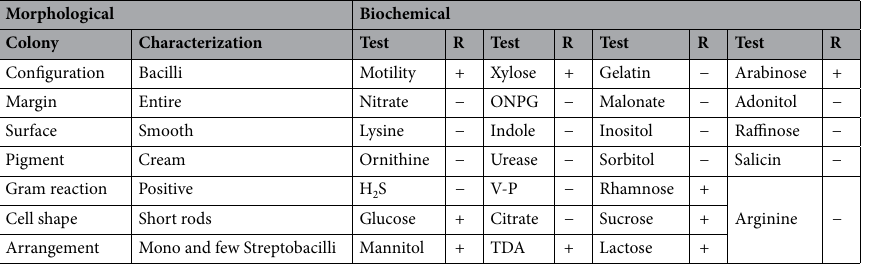
Table 1. Morphological and biochemical characteristics of L. plantarum AS.6. R, Result; ONPG, Hydrolysis of o-nitrophenyl-ß-d-galactopyranoside; (ONPG) by action of ß-galactosidase and VP test, Voges-Proskauer test.